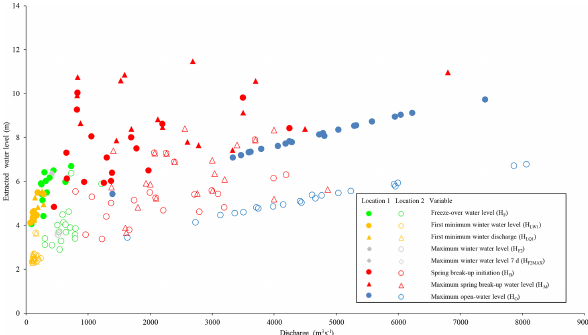
Figure 13. A stage–discharge plot of Canadian River Ice Database variables for the Albany River site near Hat Island (04HA001). Time series (1964–2015) symbols are separated into location 1 and location 2 to illustrate the effect of the gauge being moved approxi- mately 3.5km downstream on 29 September 1988. Since the stage– discharge relationship is invalid during ice conditions, visual in- spection of river ice variables reveals considerable scatter. The blue open-water time series (H O ) illustrate a shift caused by a station movement and the two separate data